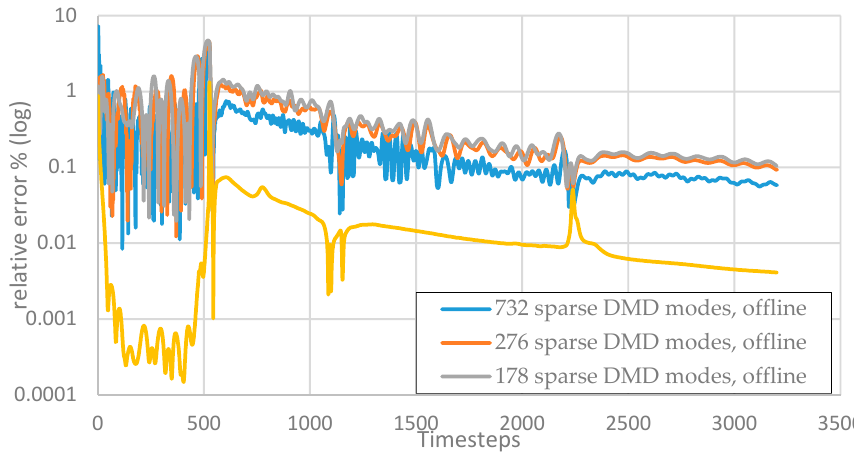
Figure 11. Relative error of pressure and velocity as the change of time in 3D reservoir. Table 3. Relative error of pressure and velocity between high fidelity and reduced model .